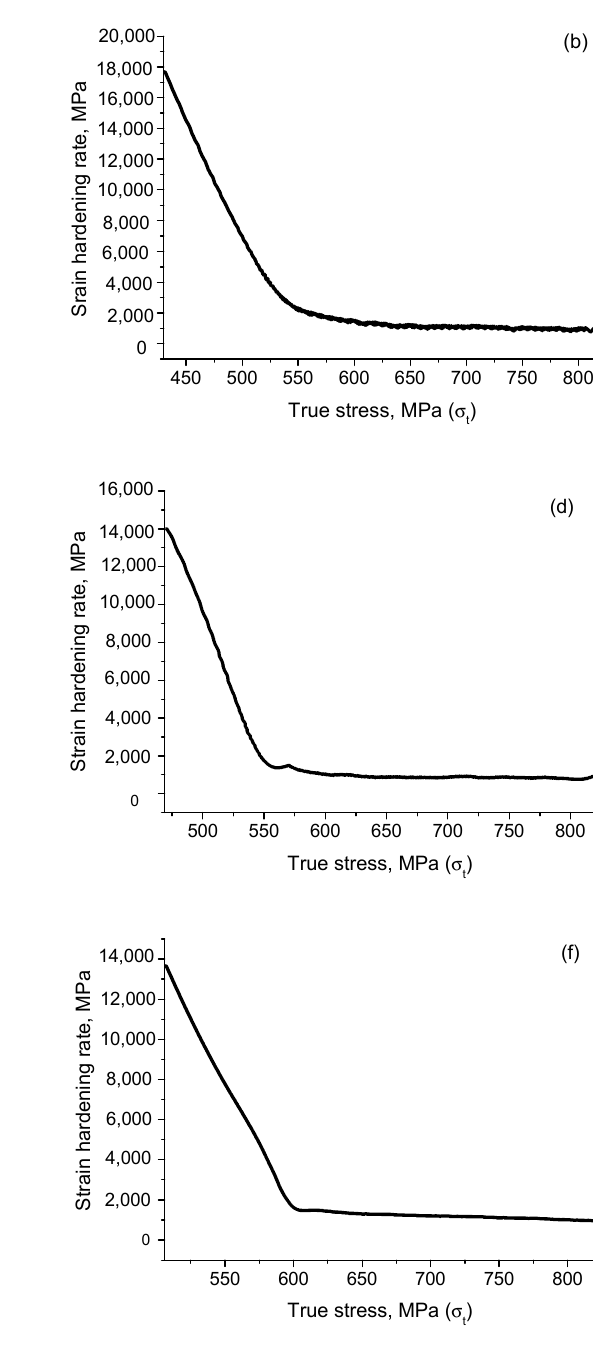
Figure 2. Results of the mechanical tests of the studied samples deformed at different strain rates: